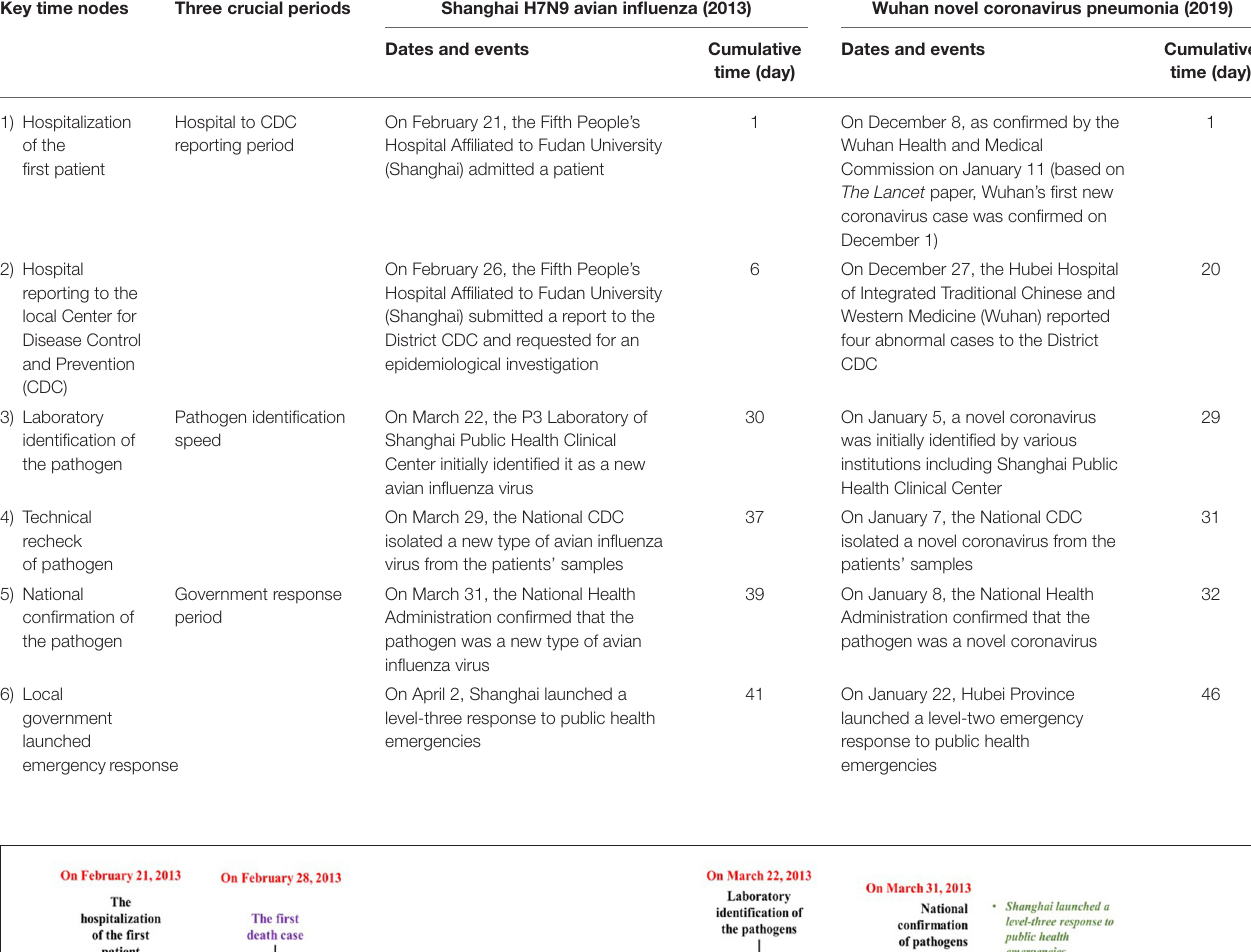
TABLE 2 | Comparison of the key time nodes of emergency disposal between H7N9 avian influenza (2013) in Shanghai and coronavirus disease 2019 in Wuhan. Key time nodes